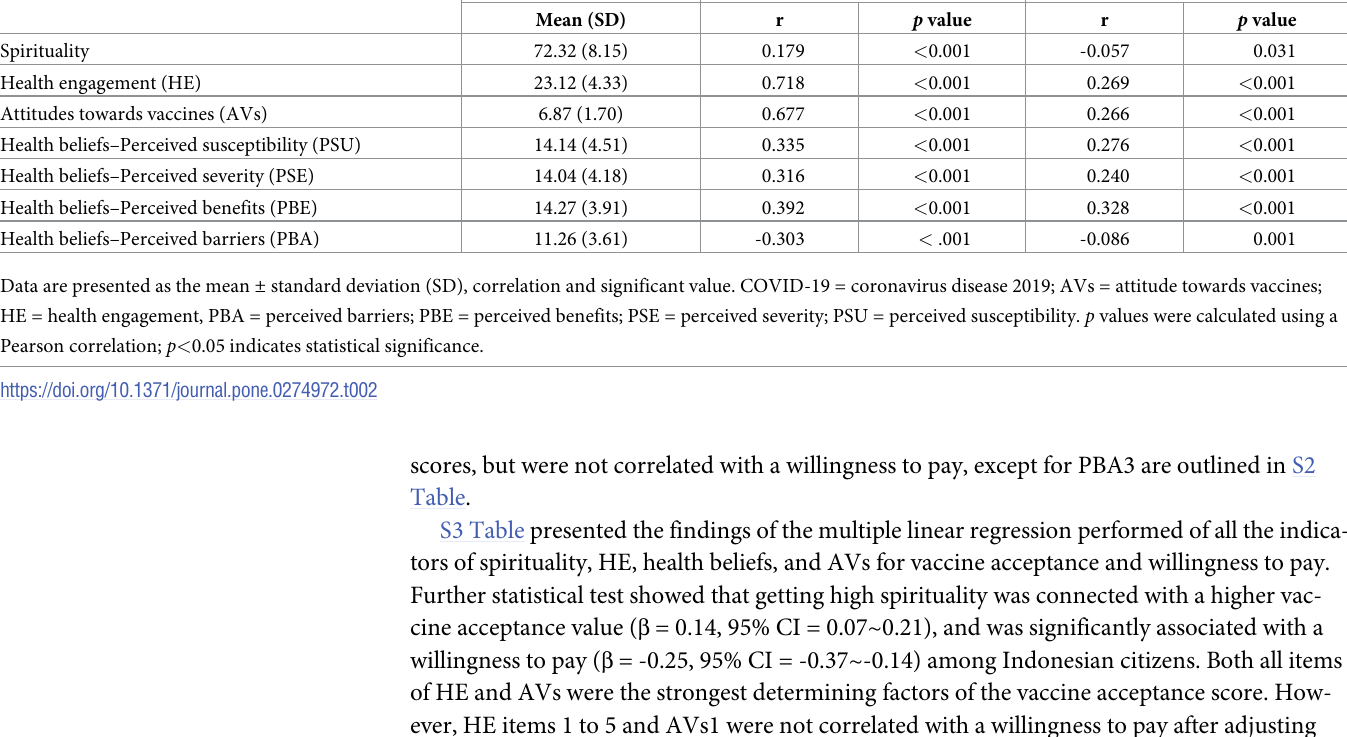
Table 2. Correlation of citizen’s spirituality, health engagement, and attitudes with their acceptance and willingness to pay for the COVID-19 vaccine ( n = 1423). Variables